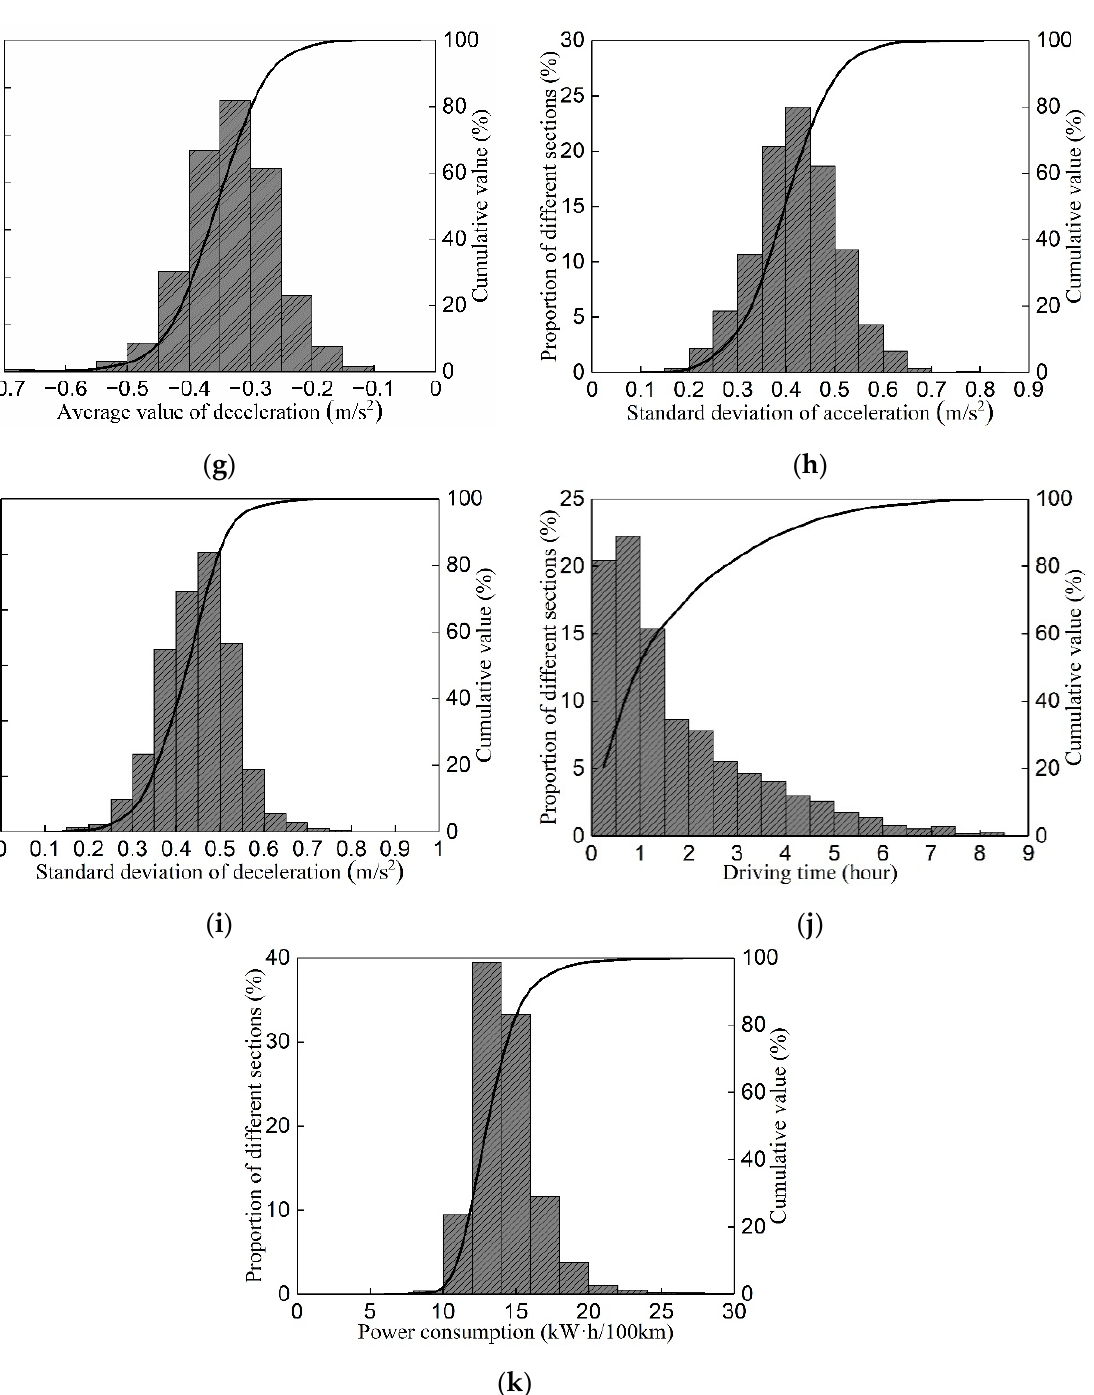
Figure 16. The distribution of different indexes: ( a ) The number of rapid accelerations per 100 km; ( b ) The number of sudden brakings per 100 km; ( c ) The number of rapid turns per 100 km; ( d ) The number of speeding occurences during steering per 100 km; ( e ) Standard deviation of vehicle speed; ( f ) Average value of acceleration; ( g ) Standard deviation of acceleration; ( h ) Average value of deceleration; ( i ) Standard deviation of deceleration; ( j ) Driving time per trip; ( k ) Power consumption. Table 9. The scoring rule of different indexes.